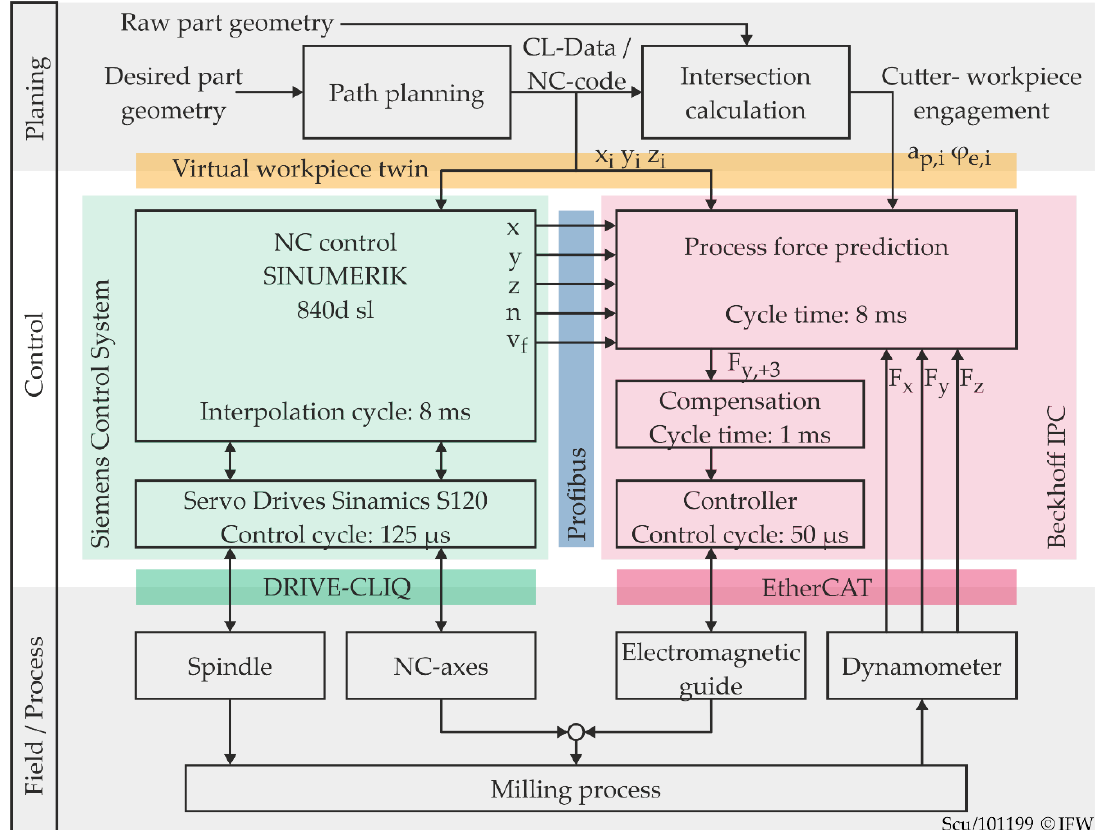
Figure 6. Information flow of the anticipatory online compensation.